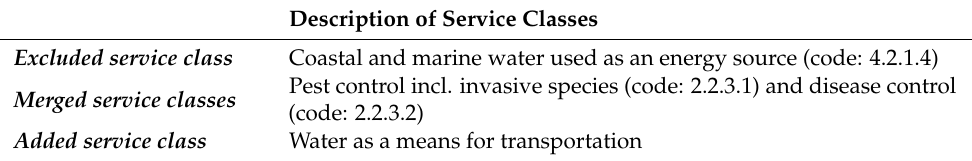
Table 3. Examples of excluded, merged, and added service classes in the water system services list for Sweden. The code refers to the CICES class code.